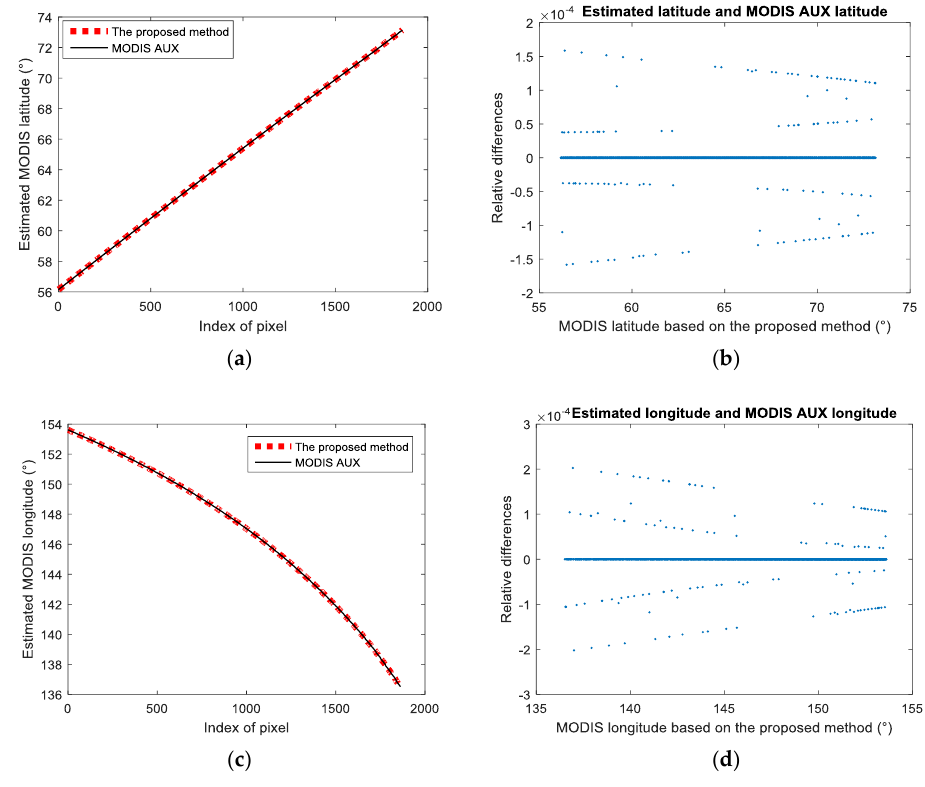
Figure 12. Scattered pixels distribution and relative differences about estimated latitudes, longitudes and those from MODIS-AUX for the granule shown in Figure 7 [38]. ( a , b ) are for latitude, while ( c , d ) are for longitude.